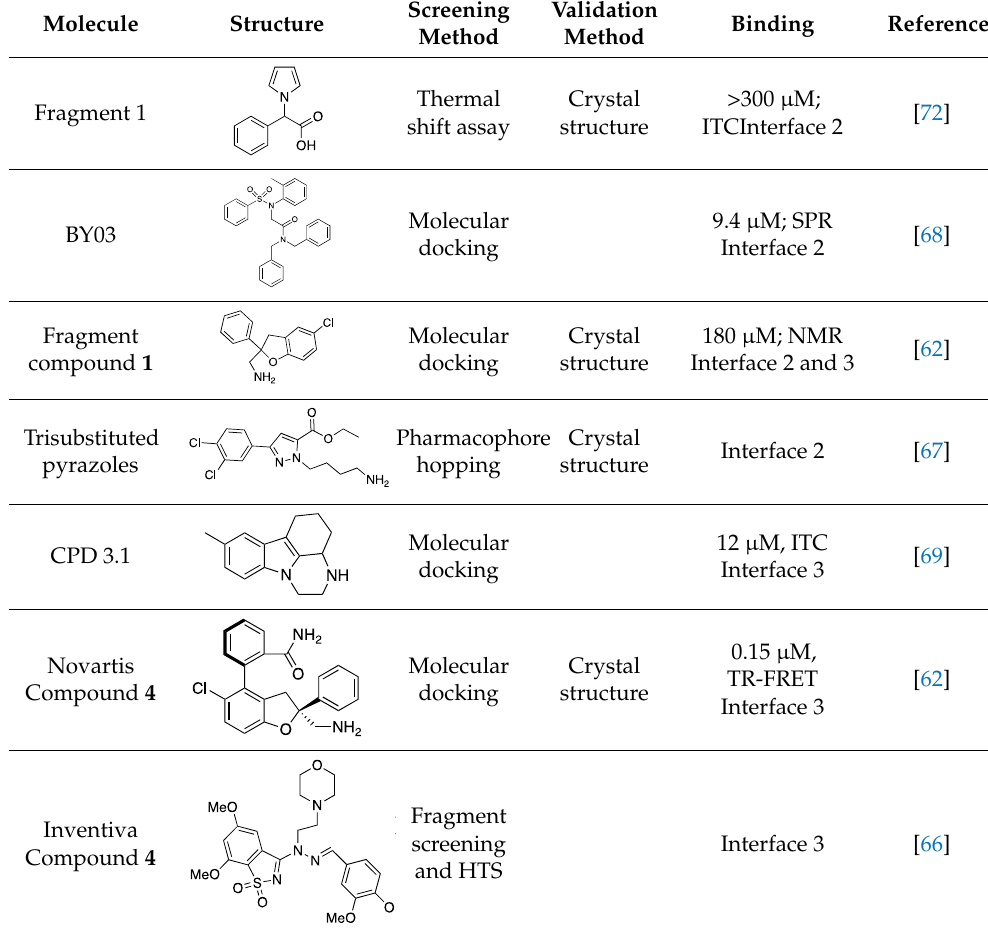
Table 1. Selected non-peptide small molecule ligands that bind on TEAD surface pocket interfaces 2 and 3.